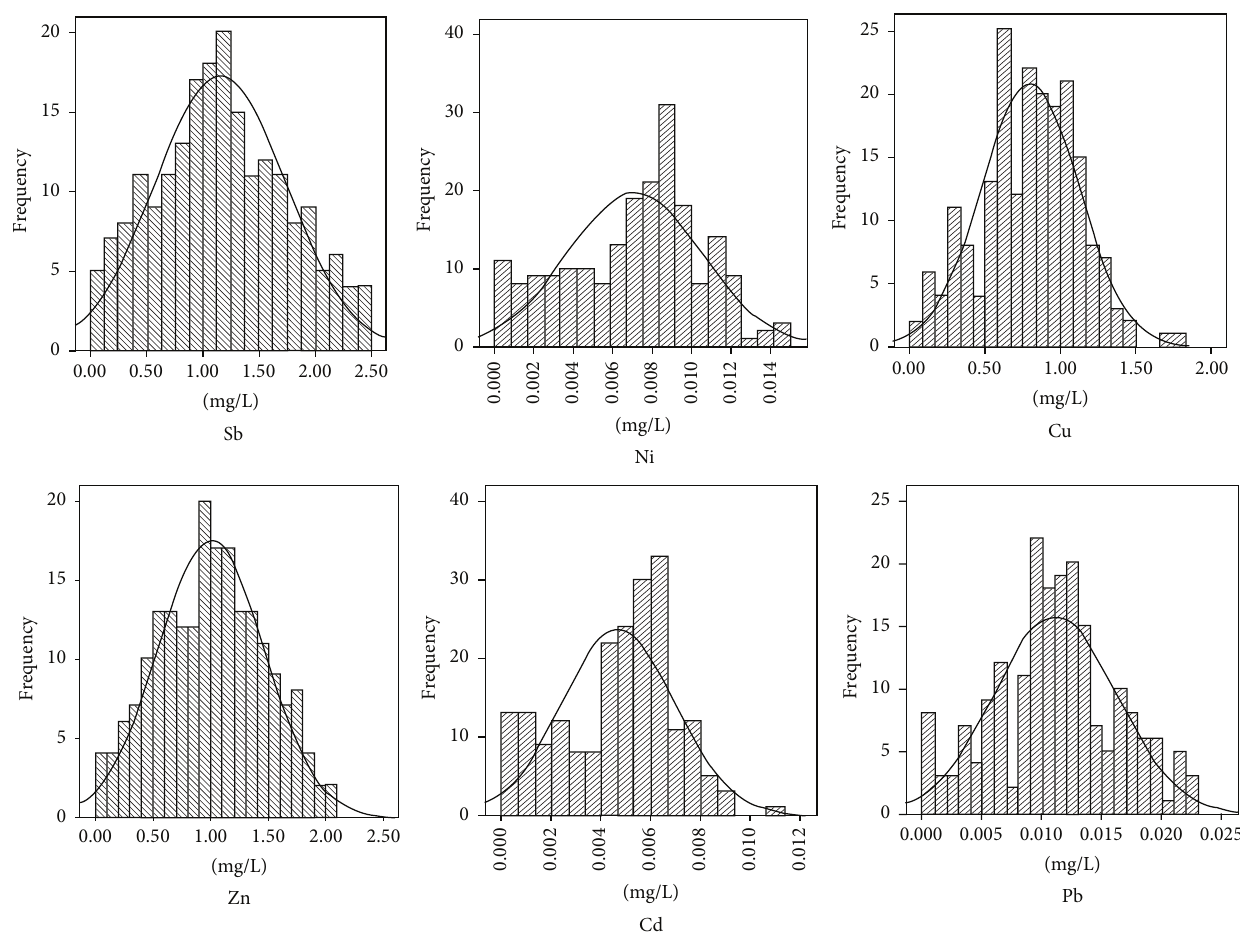
Figure 2: Frequency distributions of Sb, Ni, Cu, Zn, Cd, and Pb in surface runoff in antimony mine.